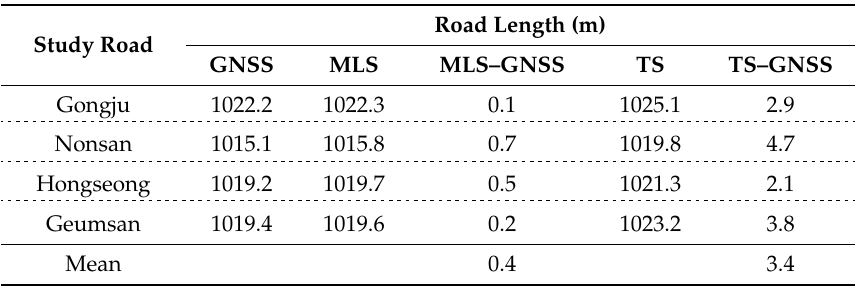
Table 5. Lengths of road routes surveyed by Mobile Laser Scanner (MLS), Total Station (TS), and Global Navigation Satellite System (GNSS) in the forest roads studied.